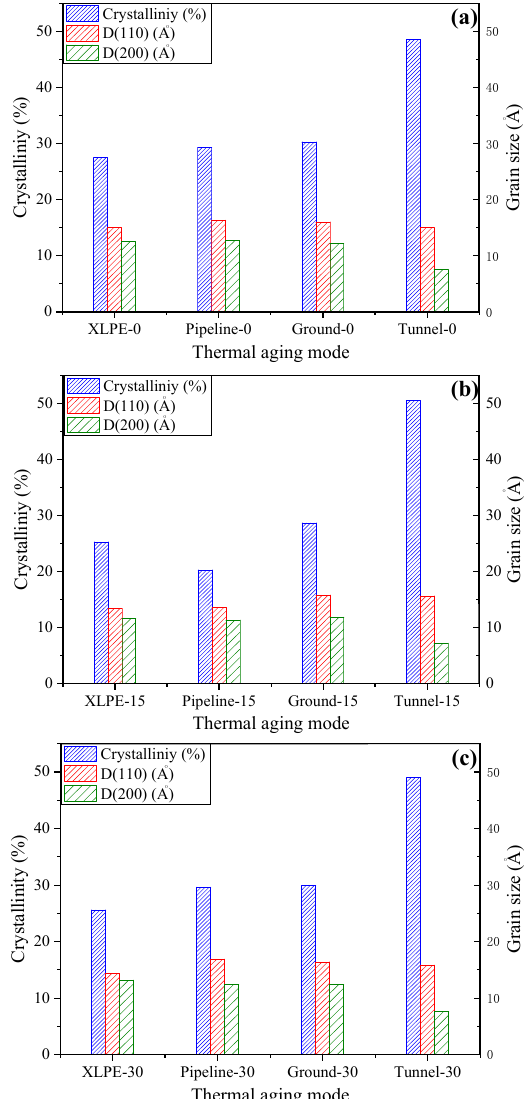
Figure 12. Changes on crystallinity and grain size perpendicular to the (110) and (200) crystal faces. ( a ) the spare cable; ( b ) the cable with service years of 15; ( c ) the cable with service years of 30. Table 6. Status of the current crystal structure of the specimens after thermal e ff ects. Specimen Pipeline Ground Tunnel XLPE-0 Improved Improved Improved Degraded Improved Improved XLPE-30 Maintained Maintained